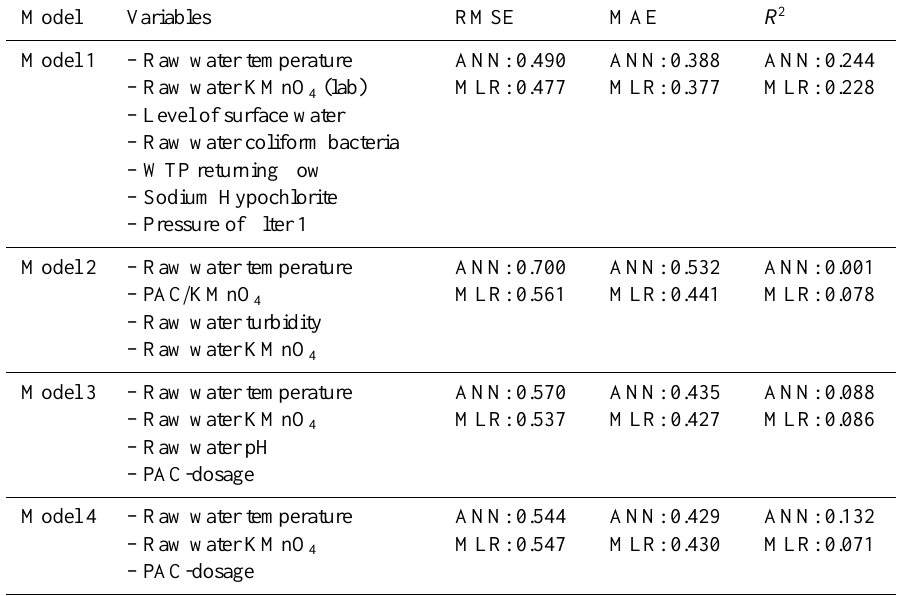
Table 2. Prediction models and goodness values of the